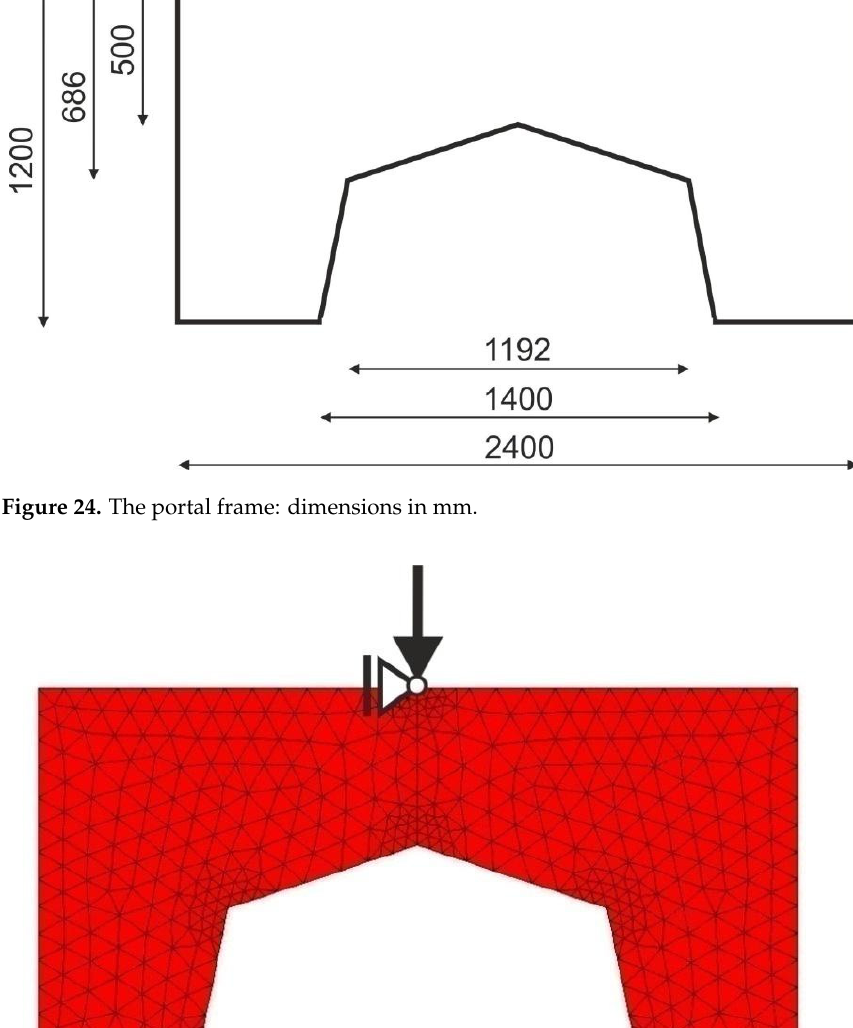
Figure 25. The design domain, loads, and supports of the portal frame.